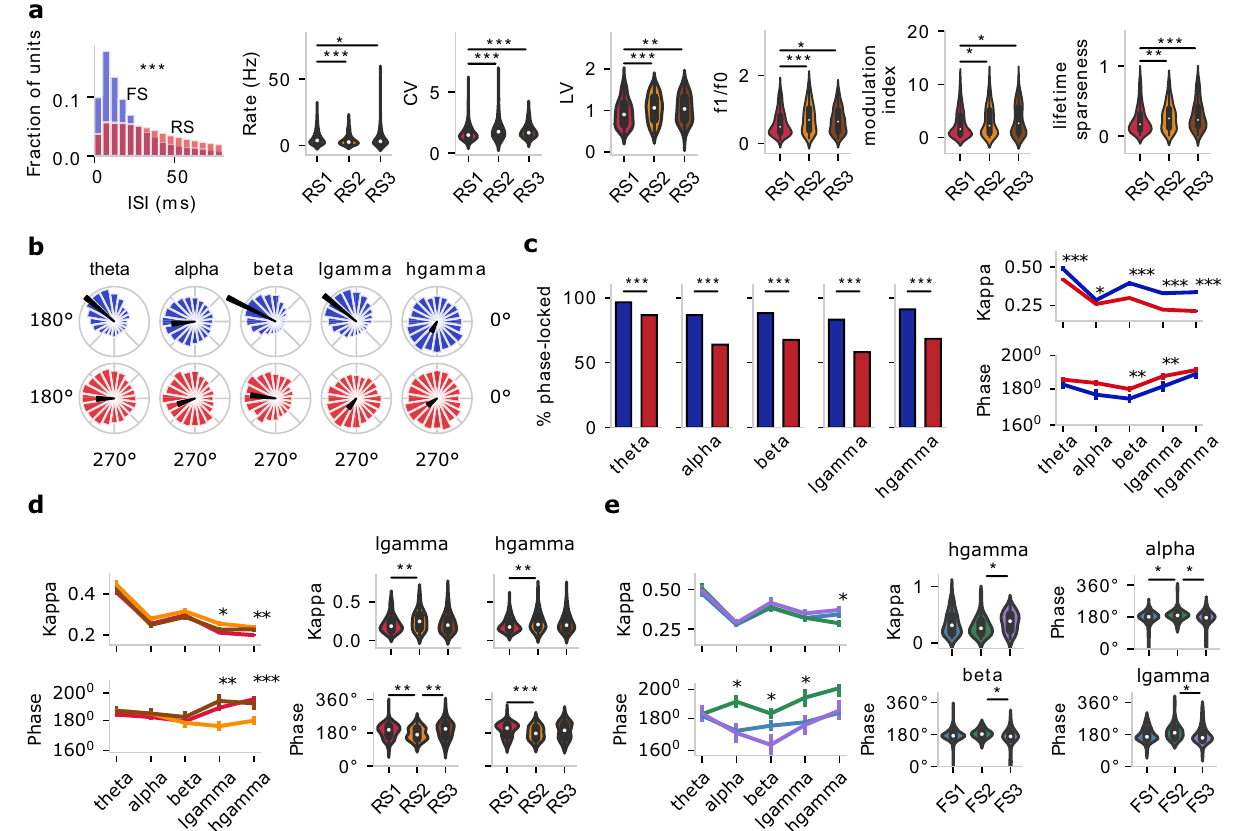
Fig. 3 | Distinct activity and response properties of one-channel and multi- channel clusters. a One-channel FS and RS clusters show distinct interspike interval (ISI) distributions (Mann – Whitney U test, two-sided, p =0.0, total 2,900,284 spikes of FS, 4,586,637 spikes of RS). Response properties of the multi- channel clusters to drifting gratings show that RS1 – 3 exhibit distinct properties in the overall excitability (spike rate, coef fi cient of variation: CV, local variation: LV, n =419 RS1, n =173 RS2, n =153 RS3) and stimulus-dependent response character- istics(f1/f0,modulationindex,lifetimesparseness, n =430RS1, n =182RS2, n =156 RS3).Kruskal – Wallis H -test; p -valuescorrectedusingtheHolm – Bonferronimethod for multiple tests. * p <0.05, ** p <0.01, *** p <0.001. b Phase distribution of exam- ples of an FS (blue) and RS (red) unit at theta, alpha, beta, low gamma (lgamma), high gamma (hgamma) frequency band (black arrow: preferred phase and kappa).